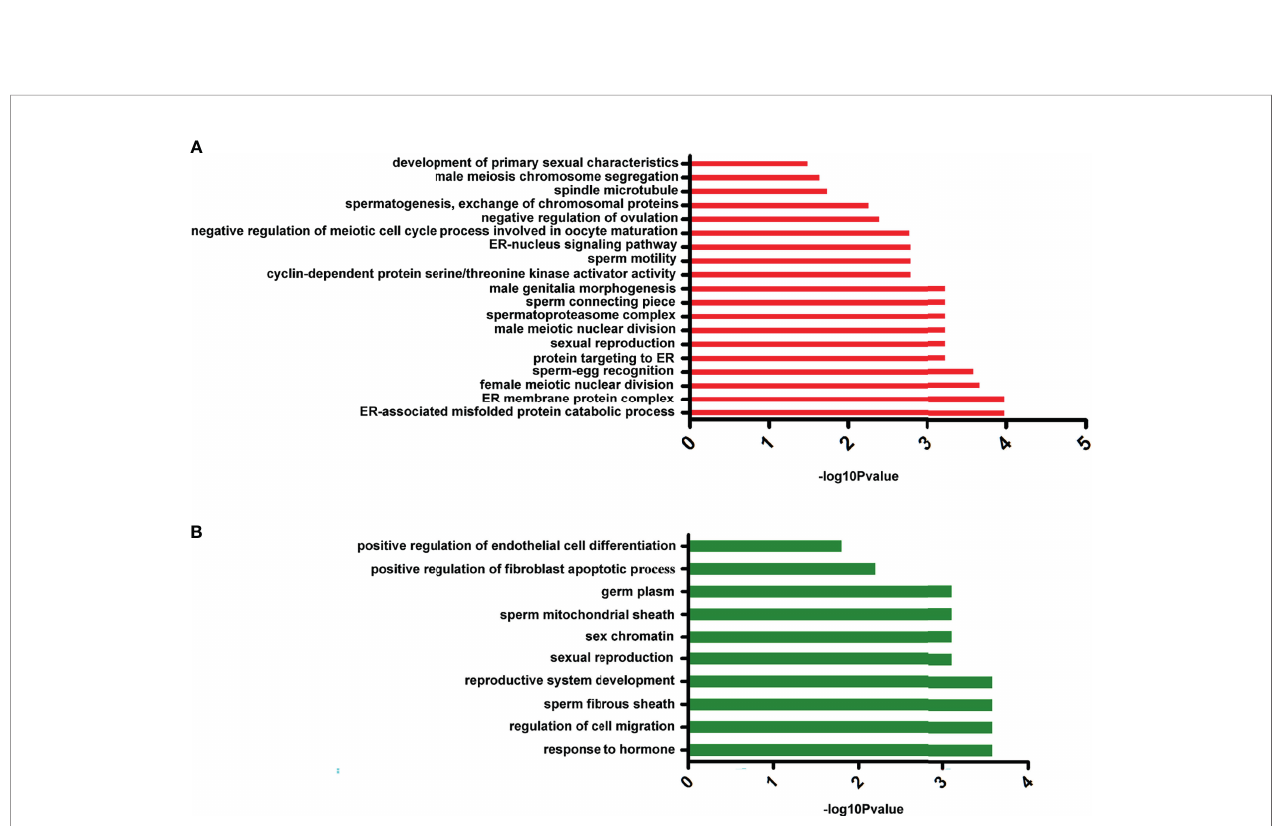
FIGURE 6 | The signi fi cant Gene Ontology (GO) annotation of differentially expressed genes. (A) The GO cluster of upregulated genes. (B) The GO cluster of downregulated